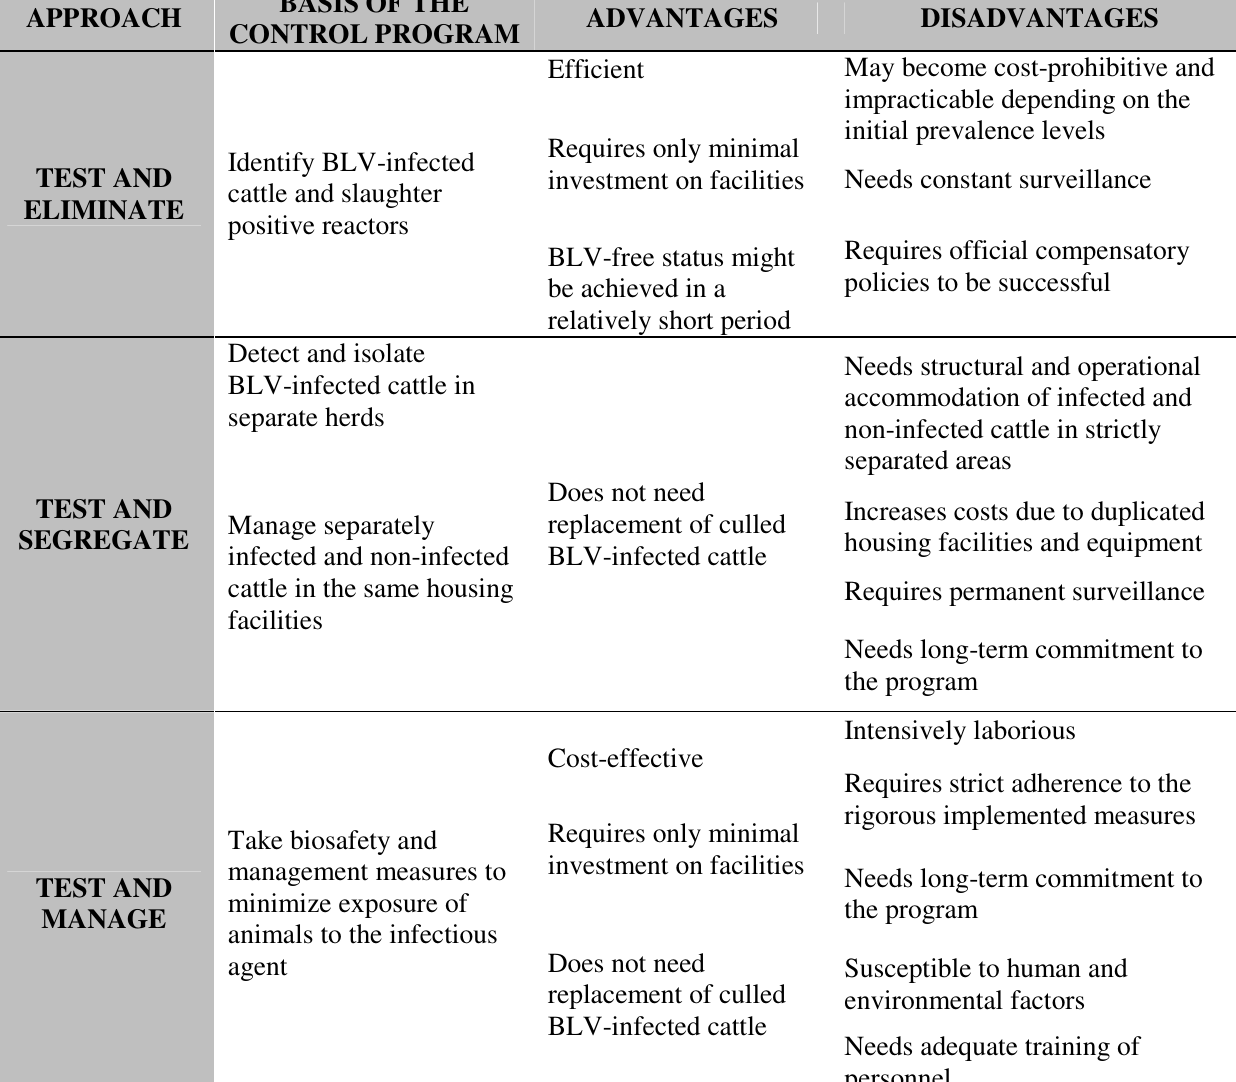
Table 1. Currently available approaches for bovine leukemia virus (BLV) control and